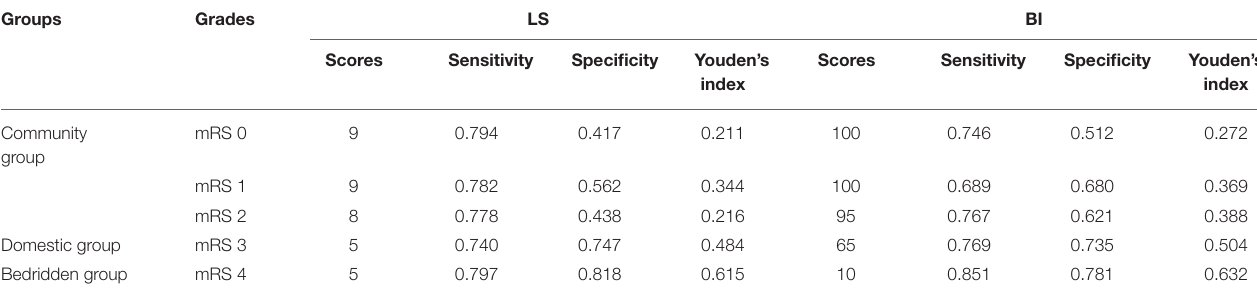
TABLE 2 | Sensitivity, specificity, and Youden’s index for LS and BI cutoff scores corresponding to mRS grades*.